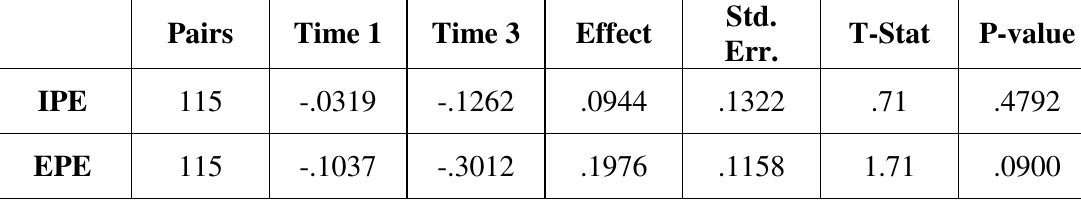
Table 10: PSM Results - IPE and EPE among Participants at Time 1 and Time 3